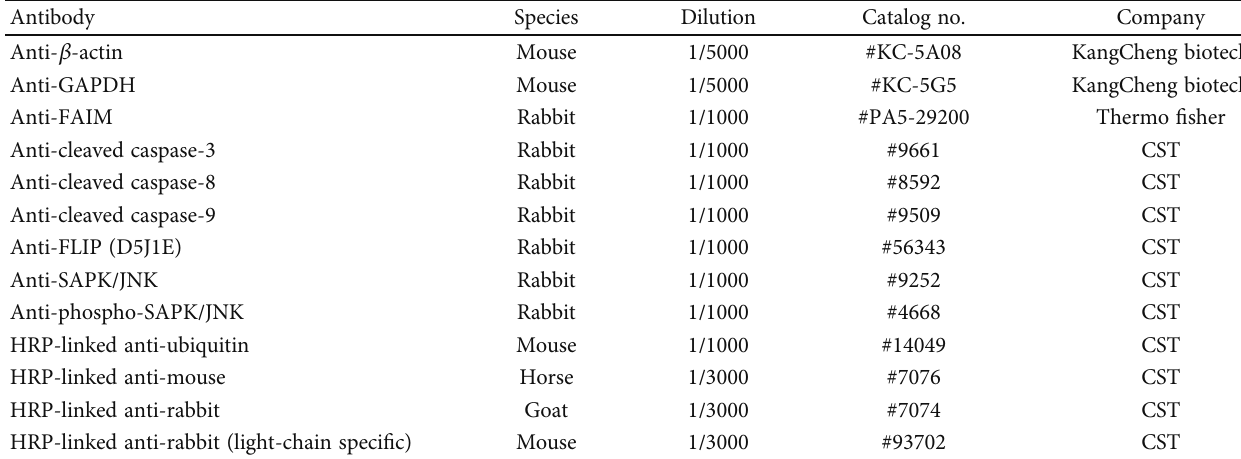
Table 3: Antibodies used for immunoblotting.